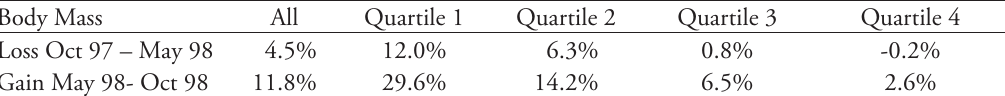
Table 4. Pregnancy status of female reindeer of the Seiland herd, divided into body mass quartiles in March and May 1998. Pregnancy status determined by plasma progesterone concentrations (bar- ren: < 7 nmo/l; pregnant: ≥ 7 nmo/l, Ropstad et al ., 1999).